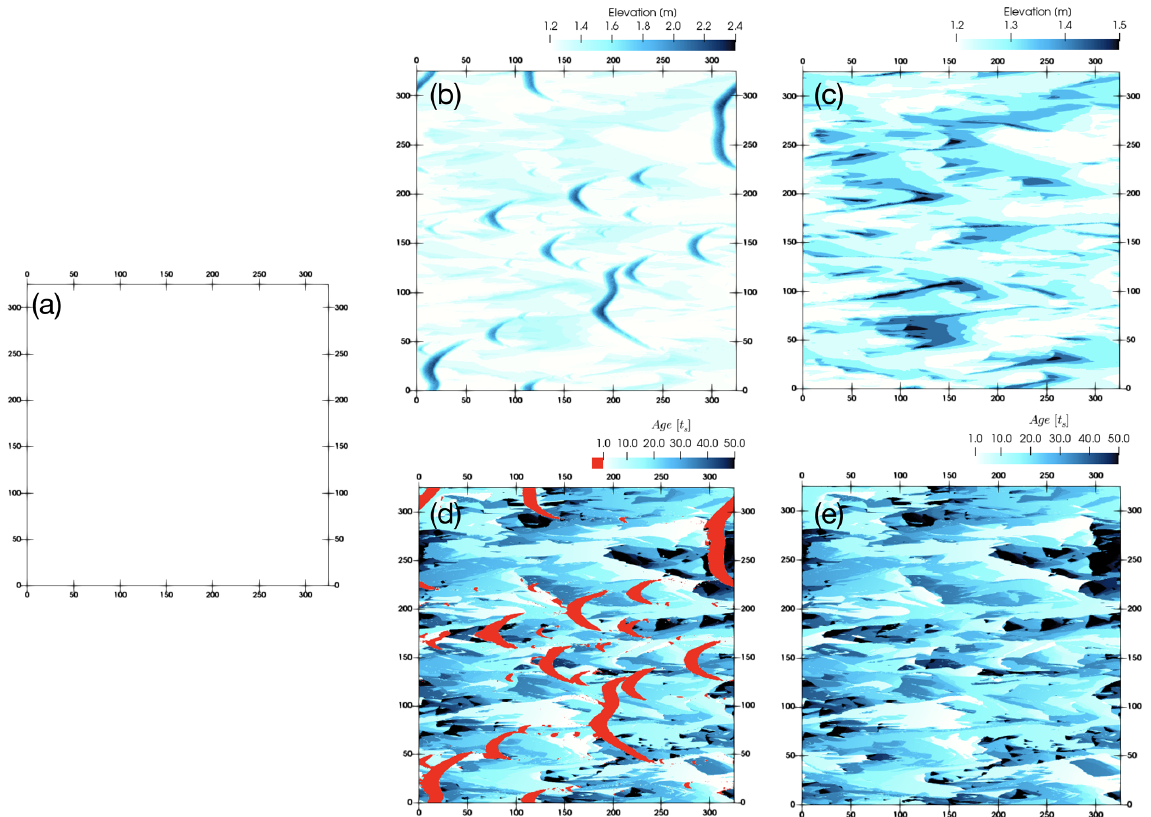
Figure 9. Evolution from an initially flat snow layer with a depth of 1.3m to a complex dune field. (a) Initial condition of the simulation. (b) Elevation map of the surface at t = 50 t s . (c) Elevation map of the sintered snow surface with the eDS-type cells filtered out. (d) Age of the surface with eDS-type cells coloured in red. (e) Age of the surface with eDS-type cells filtered